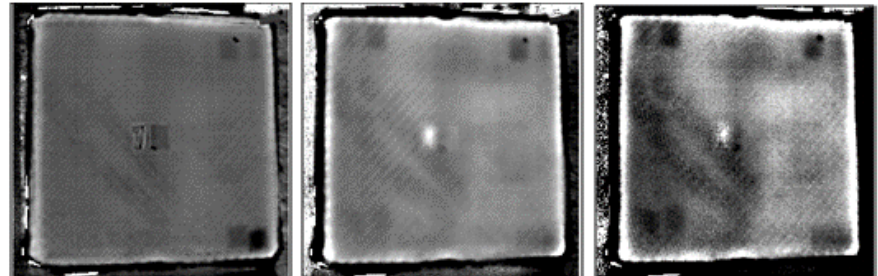
0.1 Hz ( left ), 0.15 Hz ( middle ) and 0.18 Hz ( right